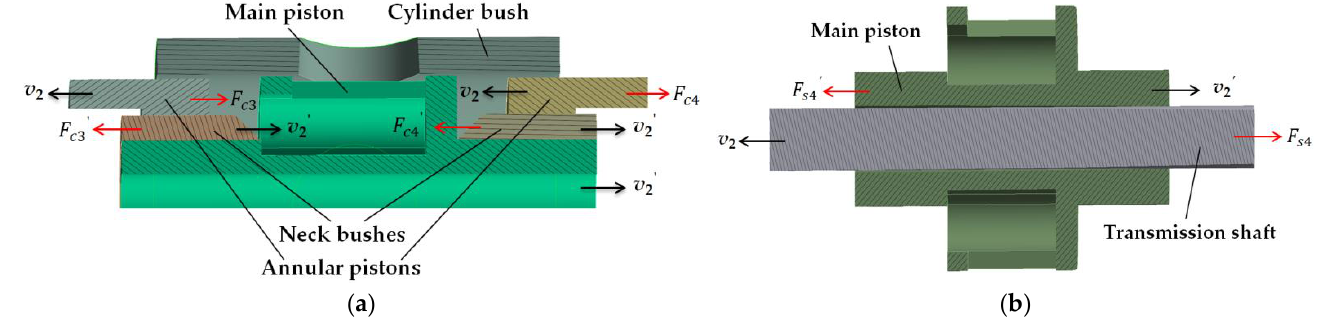
Figure 9. The axial shearing forces: ( a ) between the annular pistons and neck bushes; ( b ) between the main piston and transmission shaft.